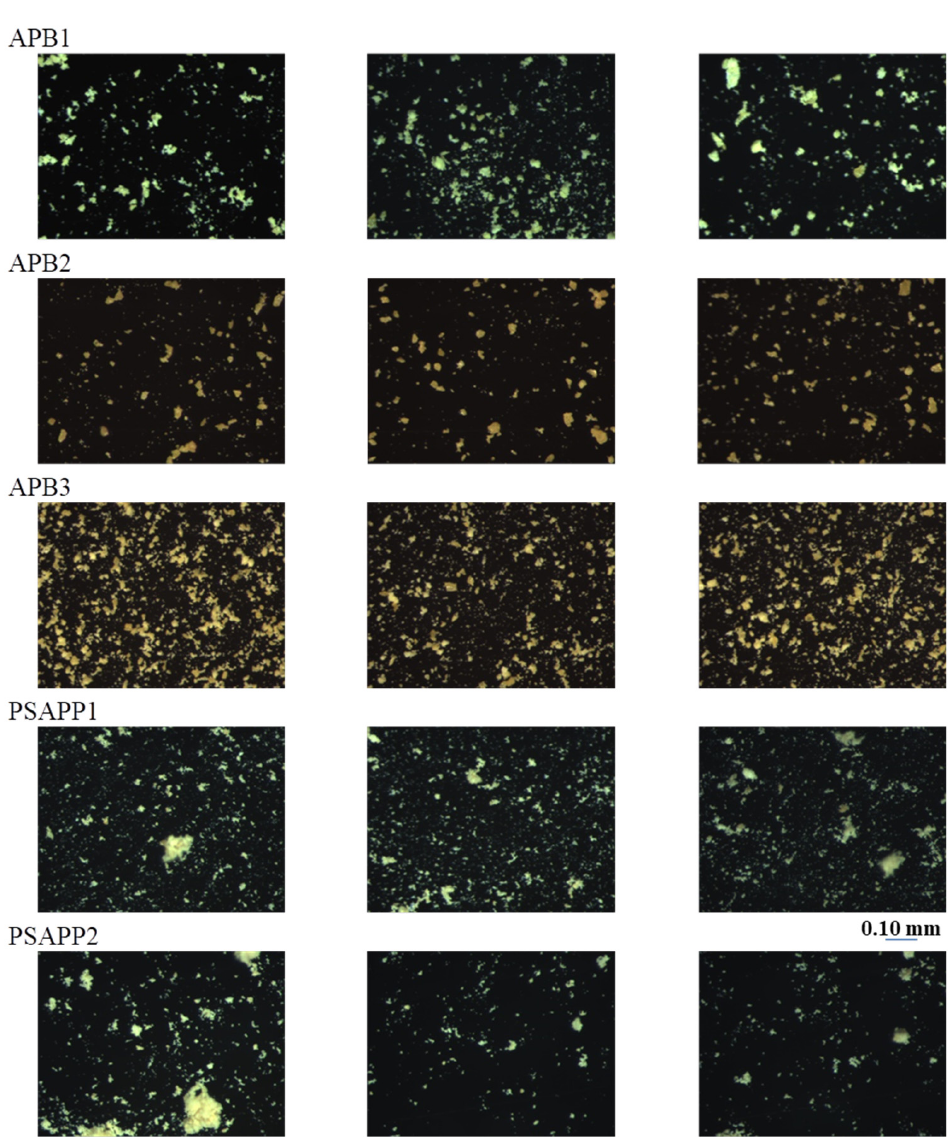
Figure 2. Stereo microscope photomicrographs of the three selected areas for each sample at 160× magnification, under reflected light.